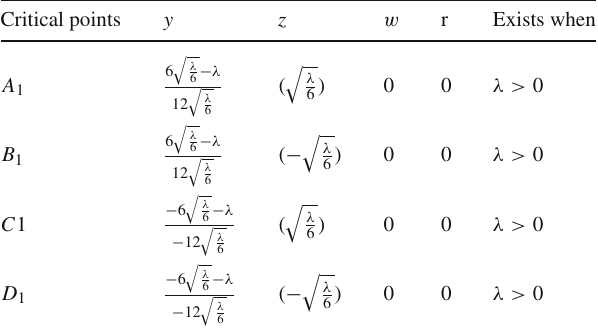
Table 5 Critical points of this system of equations Critical points Exists when